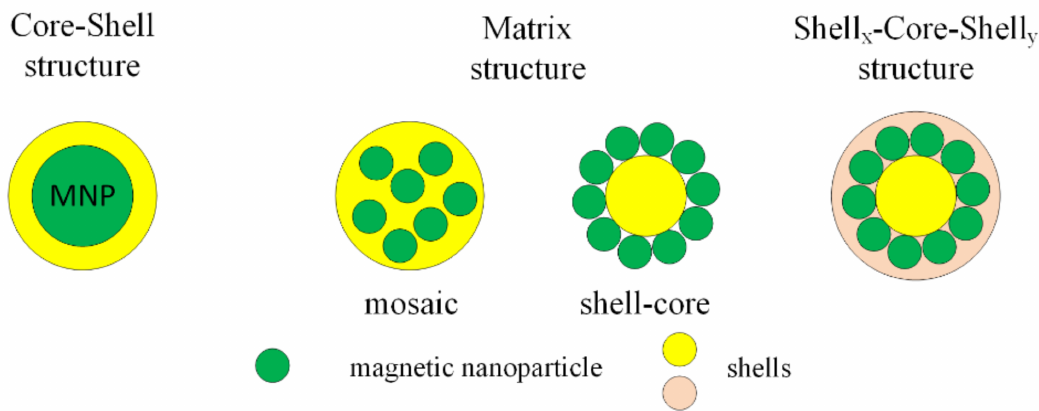
Figure 5. Classification of functionalized structure types with organic